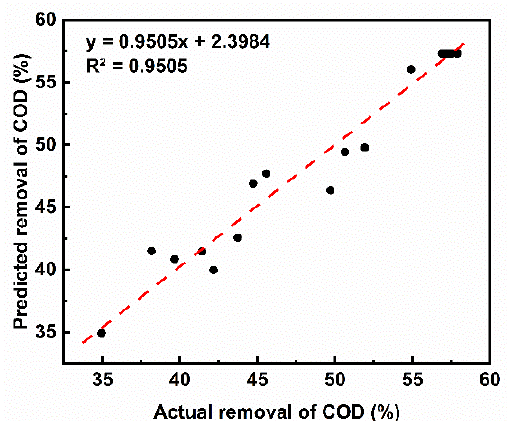
Figure 6. The removal of COD: Comparison of actual value and predicted value.